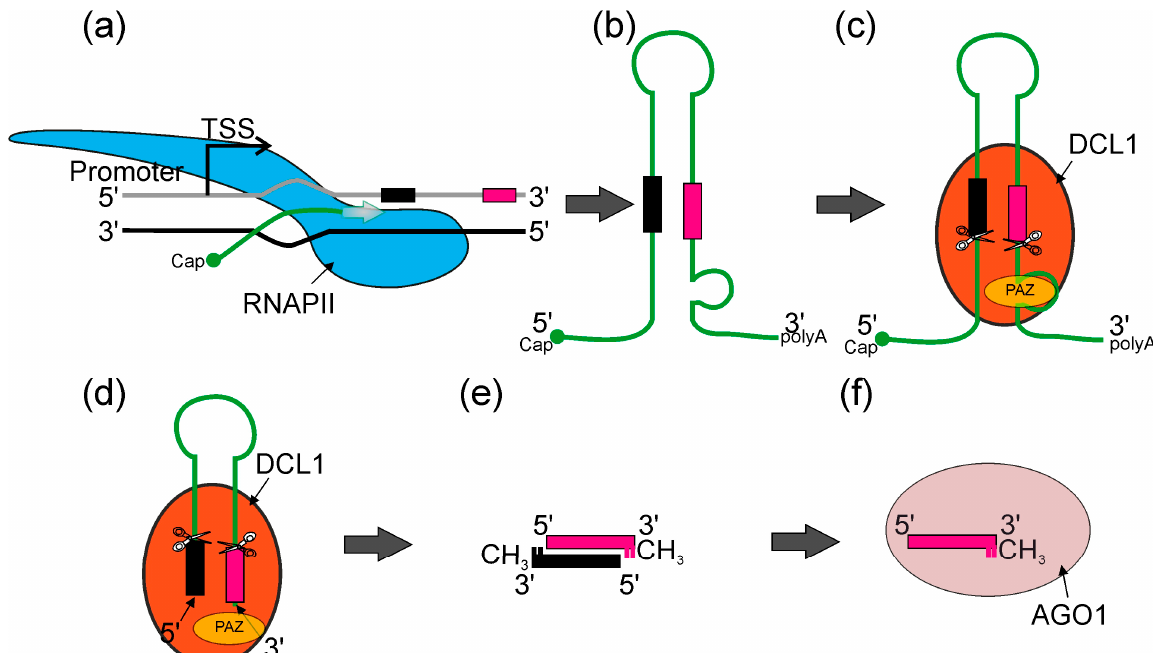
Figure 2. An overview of canonical miRNA biogenesis in plants. ( a ) RNA POLYMERASE II (RNAPII, blue) synthetizes pri-miRNA transcripts which are co-transcriptionally capped and polyadenylated (miRNA*—black bar—and miRNA—magenta bar). ( b ) Pri-miRNA transcripts form stem–loop structures. ( c ) Pri-miRNA transcripts are recognized by DICER-LIKE1 (DCL1) (orange) and other microprocessor proteins (not shown), then pre-miRNAs (stem–loop RNA) are excised with DCL1. DCL1 PAZ domain (yellow) recognizes the internal loop within pri-miRNA and RNase IIIa and RNase IIIb domains (scissors) cut in both strands, leaving two nucleotides overhang on 3 ′ end of the pre-miRNA. ( d ) Pre-miRNA molecule is translocated towards the PAZ domain and stopped when 3 ′ overhang reaches the PAZ domain. Then, DCL1 performs the second cut and produces miRNA/miRNA* dsRNA duplexes. ( e ) Later, 3 ′ ends of each RNA strand undergo methylation. ( f ) ARGONAUTE1 (AGO1) (light pink) binds miRNA and forms together the miRISC (RNA-INDUCED SILENCING COMPLEX).